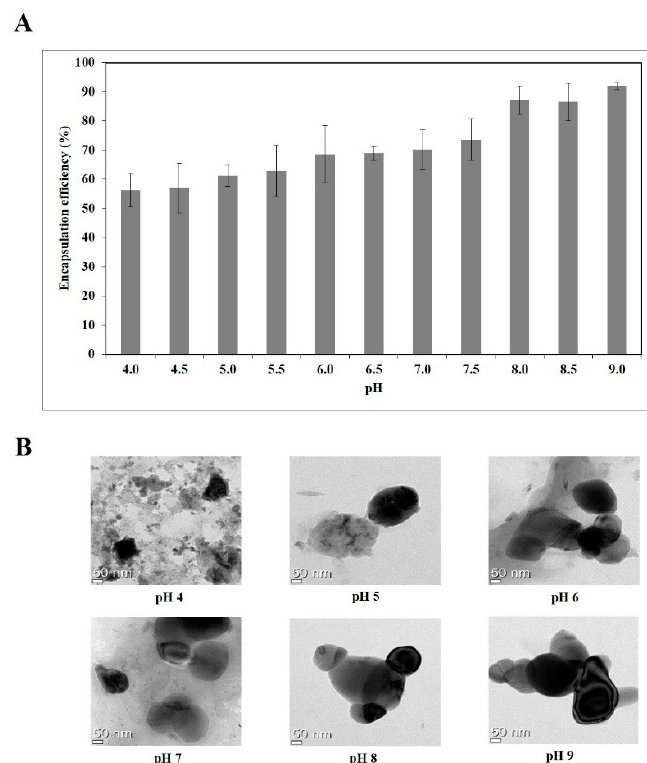
Figure 1. Encapsulation efficiency ( A ) and TEM images ( B ) of quercetin-loaded nanoemulsion with different pH.